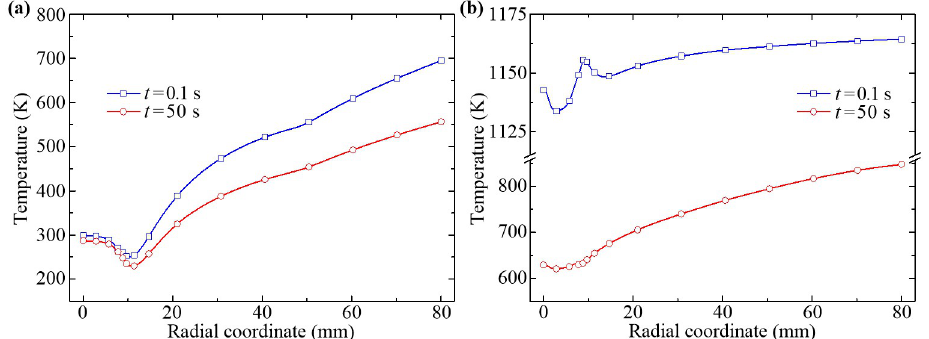
Fig 13. Comparisons of the radial temperature distributions at time 0.1 s and 50 s. (a) Wall-adjacent fluid, (b) Disk upper-wall.